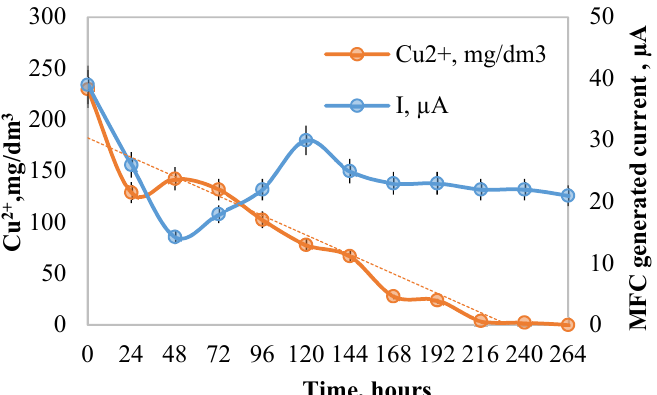
Figure 7. MFC reactor used in the copper removal experiments; 1—anode, 2—cathode, 3—PEM, 4—external circuit and resistor